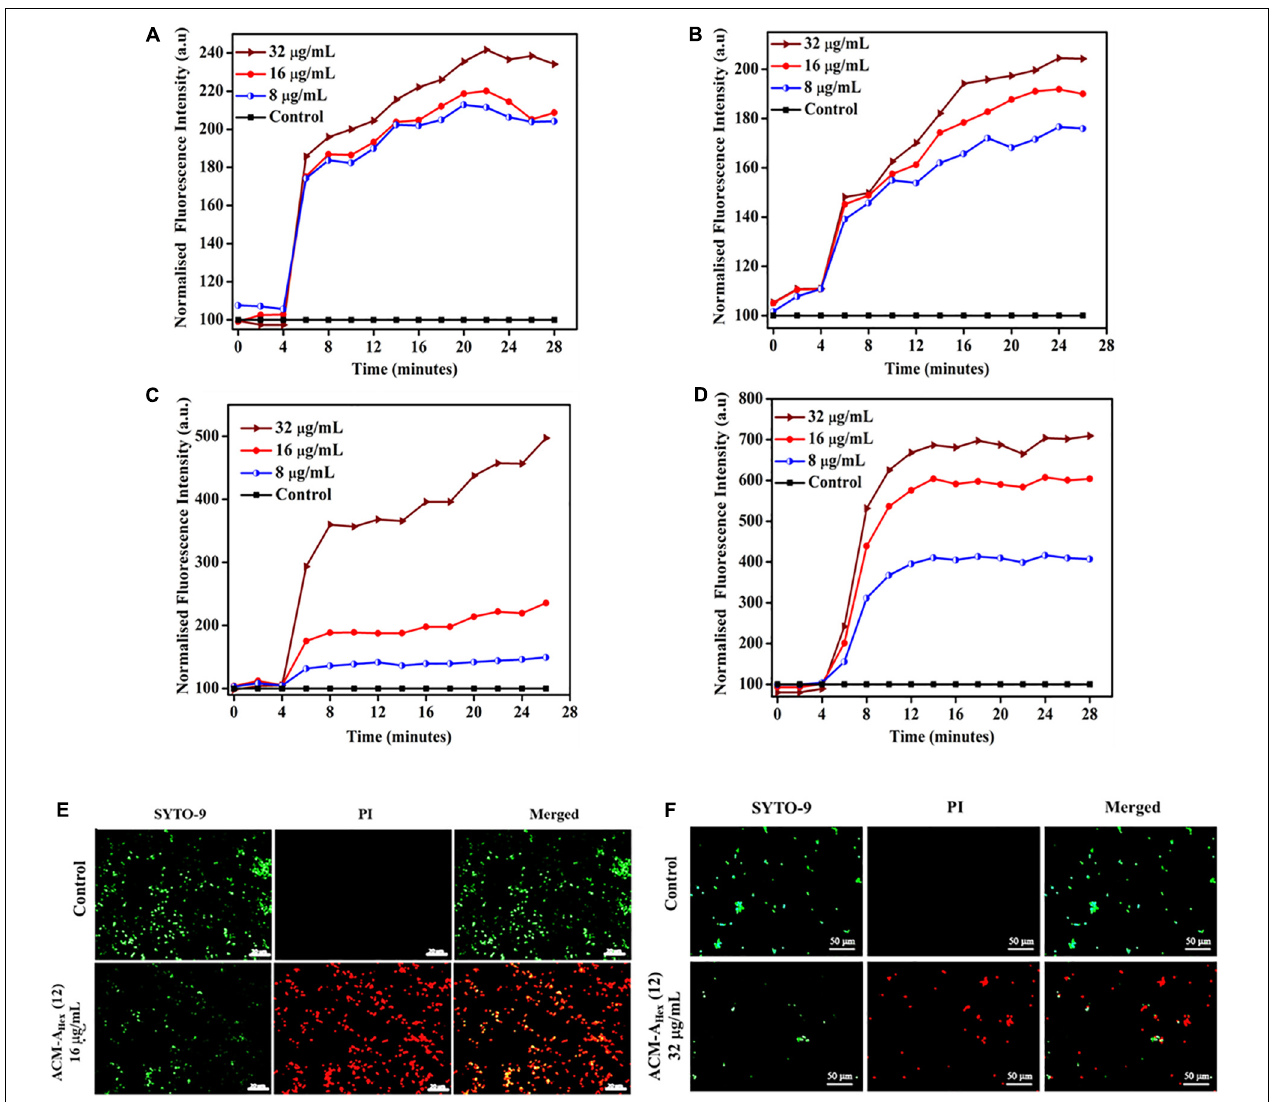
FIGURE 7 | Membrane active mechanism of action by ACM-A Hex ( 12 ) : membrane depolarization against (A) growing planktonic MRSA ATCC33591; (B) stationary phase MRSA ATCC33591; Membrane depolarization against (C) C. albicans ATCC10231 and (D) C. albicans AB226. (E) Life-Dead assay against MRSA ATCC33591. Scale bar is 20 µ m. (F) Life-Dead assay against C. albicans ATCC10231. Scale bar is 50 µ